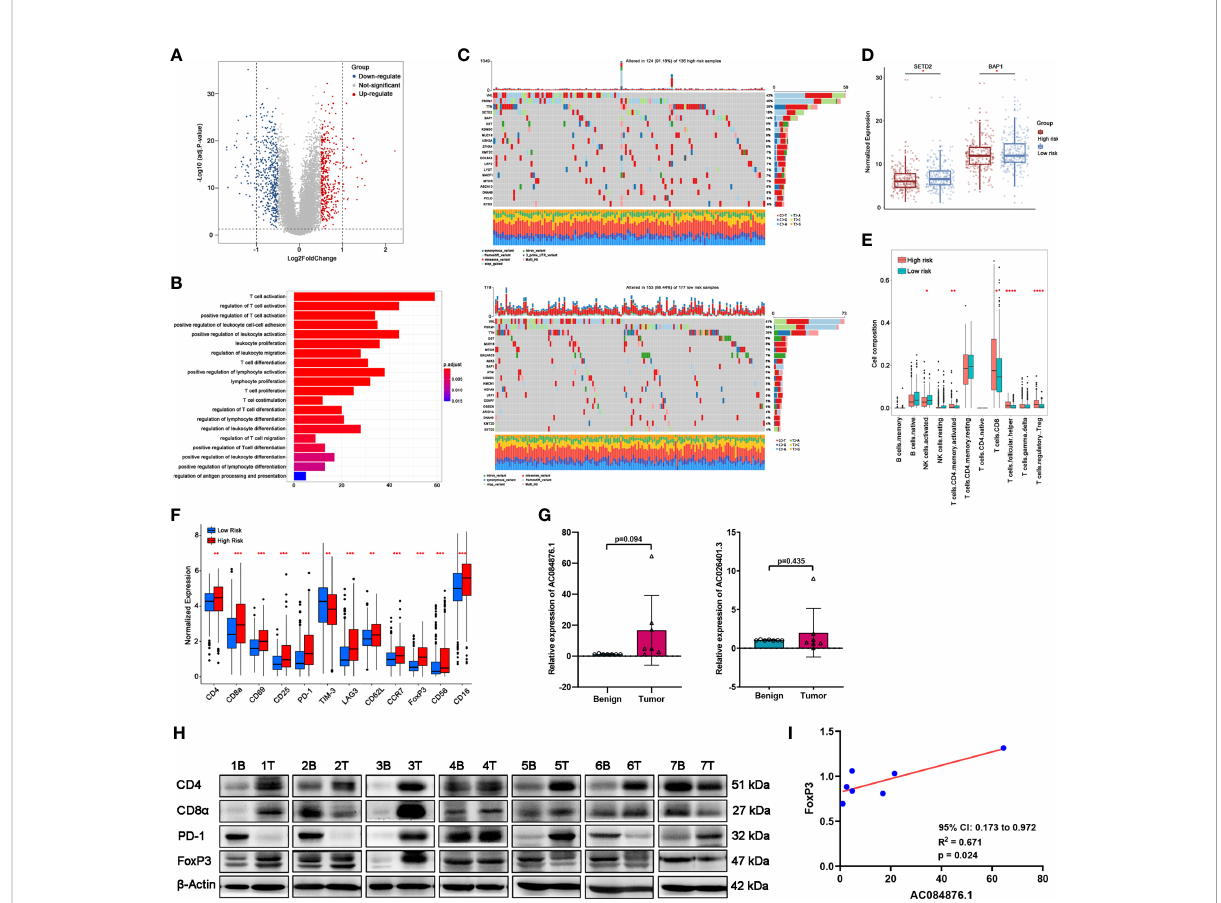
FIGURE 6 Correlation between the signature and TILs in ccRCC tissues. (A) DEGs between the groups by volcano map. (B) GO-BP enrichment analysis. (C) Waterfall plots represent mutation information in each ccRCC patient sample in the high- and low-risk groups. (D) Expression of SETD2 and BAP1. (E) TILs composition analysis in ccRCC of TCGA cohort. (F) Expression of immune markers of lymphocytes of TCGA cohort. (G, H) The expression of AC084876.1 and AC026401.3 in seven kidney samples from ccRCC patients. (H) The expression of CD4, CD8 a , PD-1, and FoxP3 in seven kidney samples from ccRCC patients. “ B ” indicates benign renal tissue adjacent to cancer. “ T ” indicates tumor tissues of ccRCC. (I) Correlation between the expression of AC084876.1 and FoxP3 in seven ccRCC samples. * P < 0.05; ** P < 0.01; *** P < 0.001; **** P <